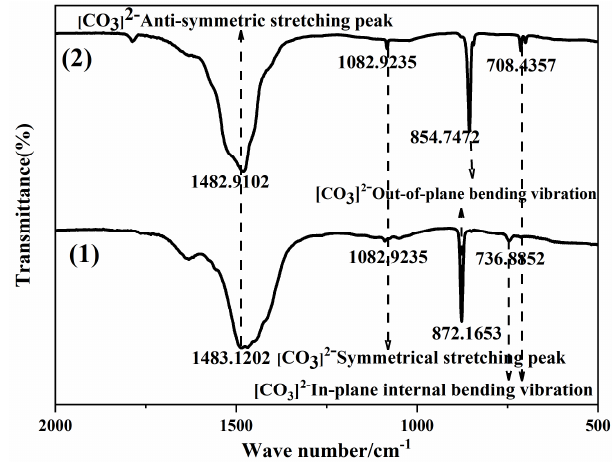
Figure 5. Infrared absorption spectrum of the calcium carbonate powder samples. (1) is aragonite, and (2) is vaterite.